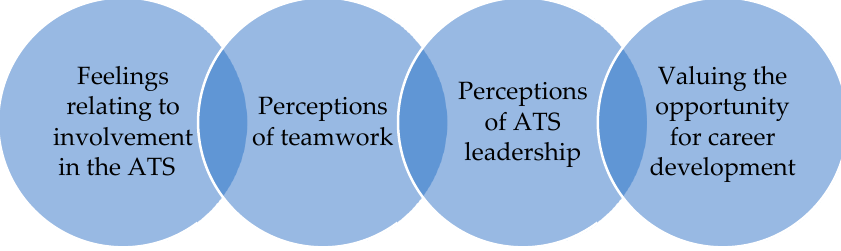
Figure 3. Overarching themes.